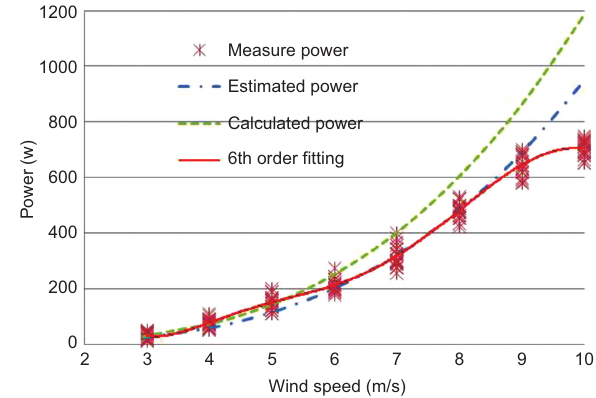
Figure 17 Static structural test of the prototype blade using the 3-points loading.